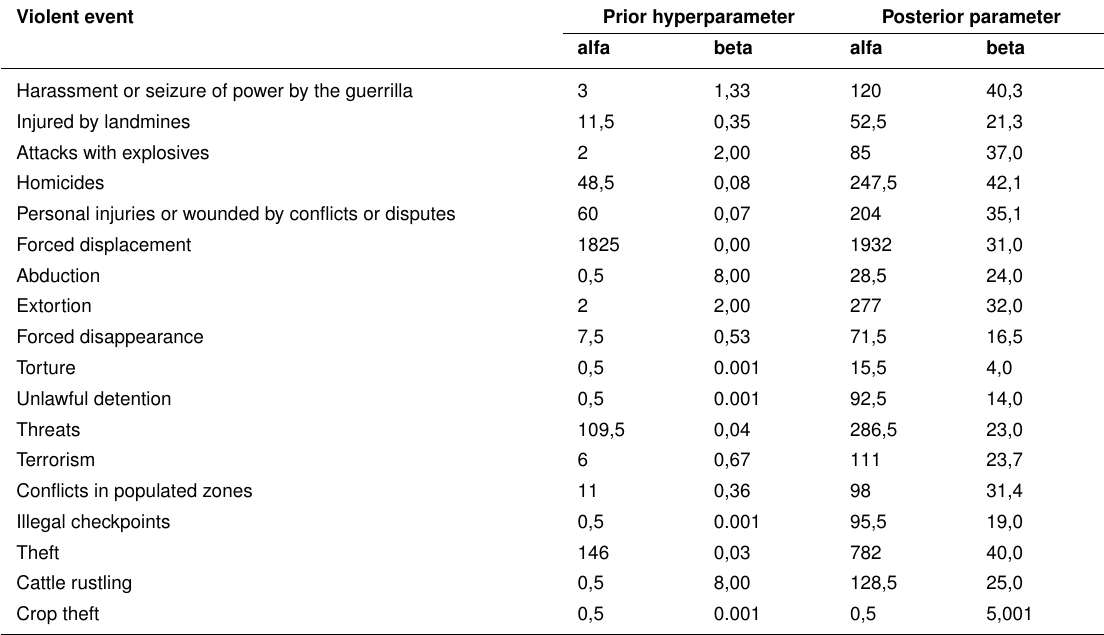
Table A2. Hyperparameters and parameters of Gamma prior and posterior distributions considered in the estimation process for expected amounts of violent events in Miranda’s municipality during the period 2010-2013. Violent event Prior hyperparameter Harassment or seizure of power by the